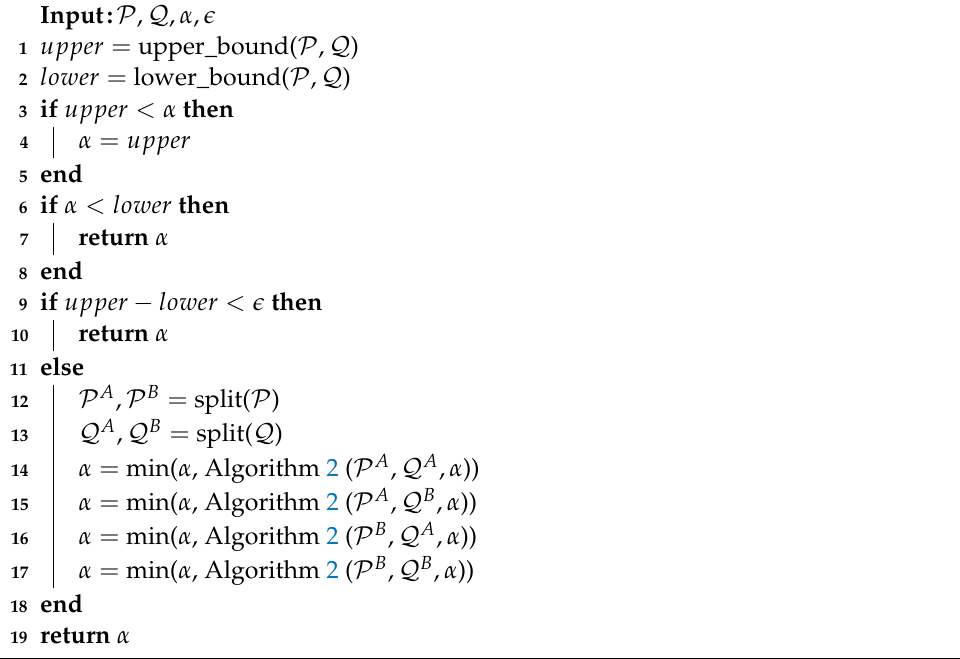
Algorithm 2: Minimum Distance Between Two Bernstein Polynomials